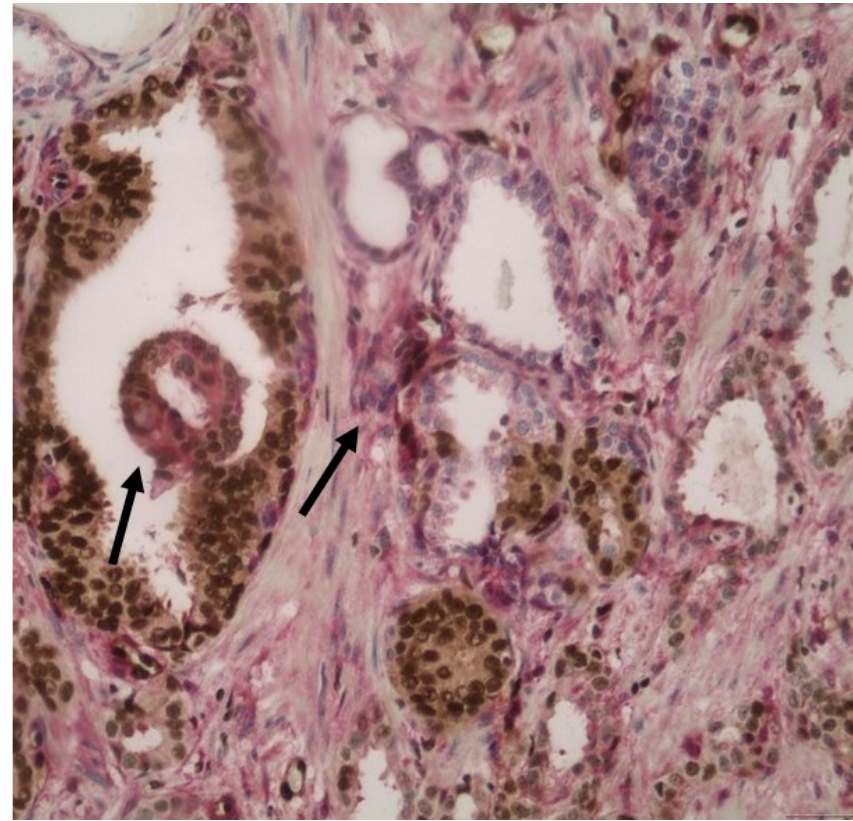
Figure 7. PTEN positivity in HGPIN (left side of the image) with concomitant PTEN positivity in adjacent low-grade invasive carcinoma (arrows showing PTEN positive focus of HGPIN and invasive glands). Simultaneous ERG nuclear expression in both HGPIN and invasive cancer ( ×